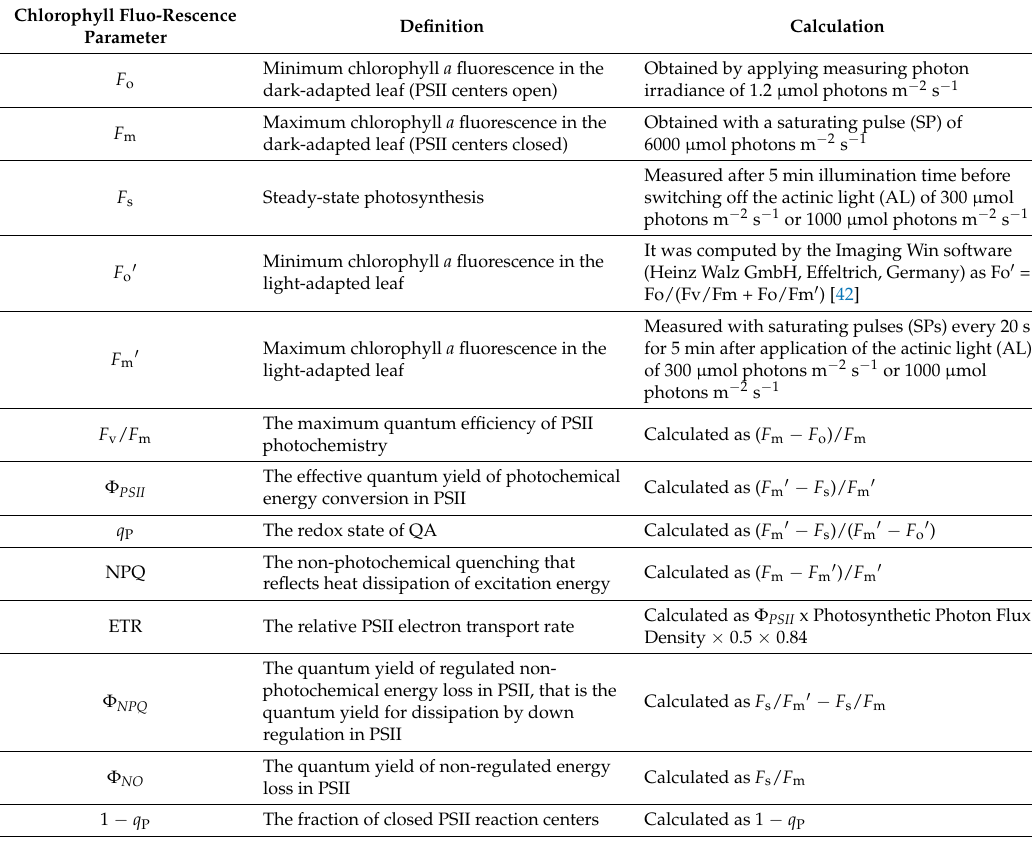
Table 1. Definitions of all measured and calculated chlorophyll fluorescence parameters.